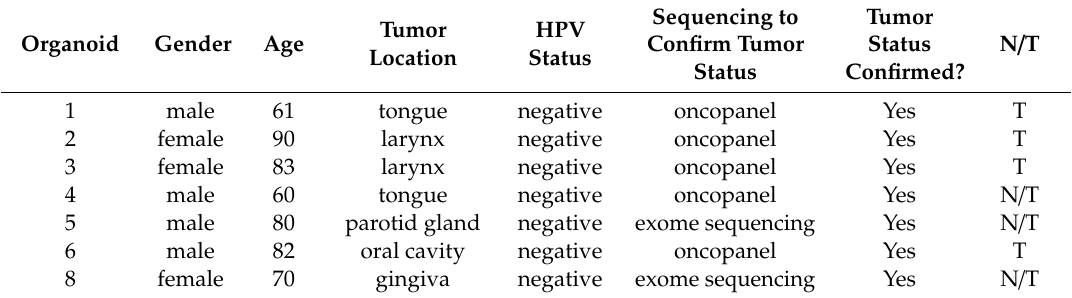
Table 2. Patient information corresponding to the organoid lines used in this study. From left to right, columns indicate: patient gender, patient age at diagnosis, tumor location, pretreatment, Human Pappiloma Virus (HPV) status of tumor, type of DNA sequencing used to confirm tumor status of the organoid line, and availability of organoids from only tumor (T) or both normal epithelium and tumor (N / T). Tumor Organoid Gender Age